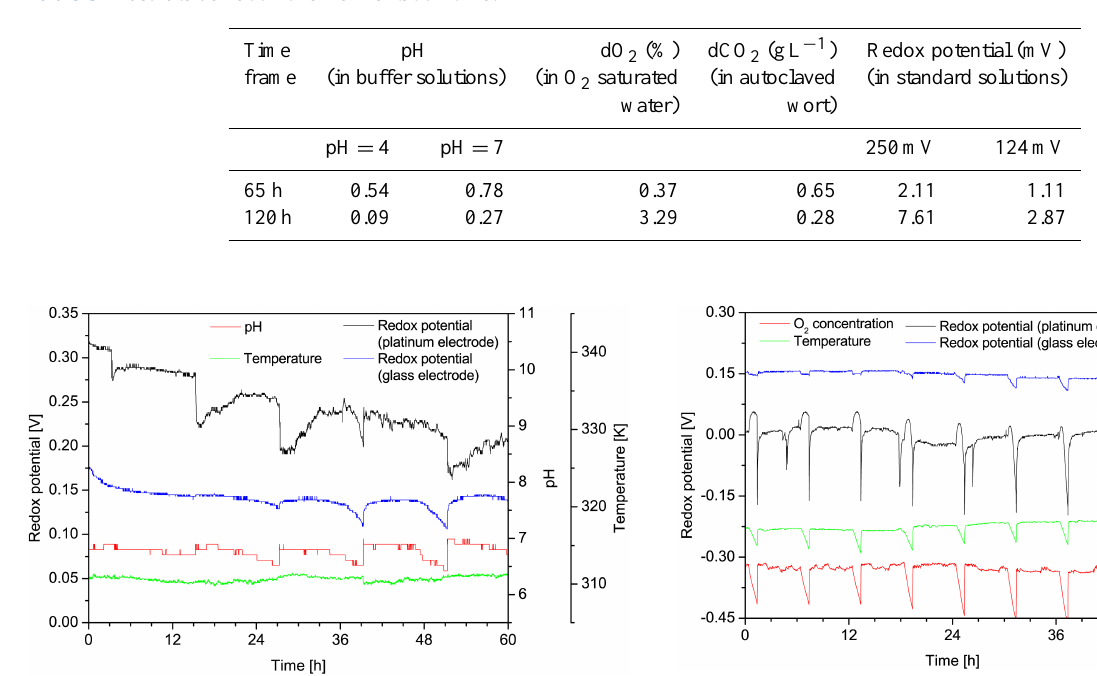
Figure 3. Left: multi-sensor probe; right: miniaturised electrodes (from left to right: reference, redox, pH electrode, temperature probe). Table 3. Absolute deviation over fermentation time.